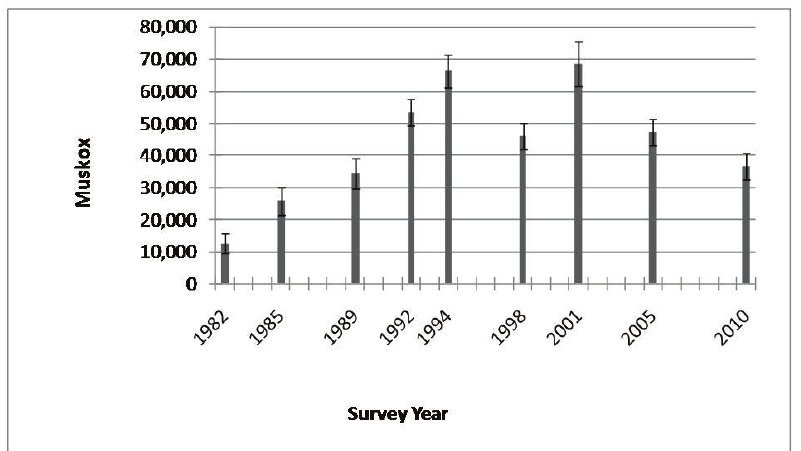
Fig. 4. Transects flown during the 2010 survey and distribution of adult mus- koxen found ‘on’ transect on northwest Banks Island,